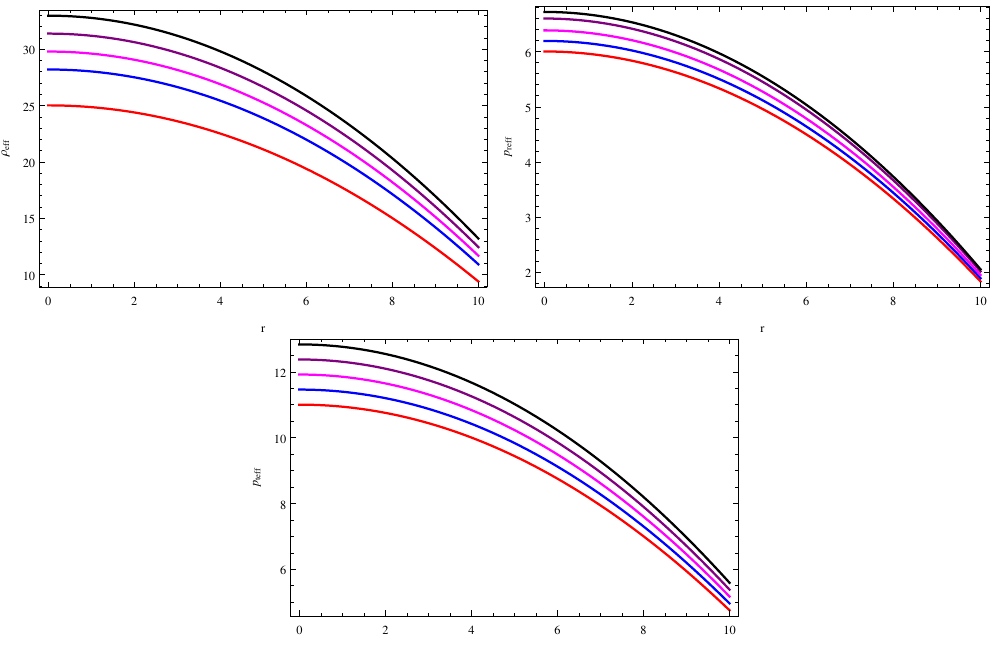
Figure 2. Plot of ρ eff , p eff r and p eff versus r for the strange star candidate LMC X − 4. The red, purple, t magenta, blue and black colors represent, respectively, cases (cid:118) = 0, (cid:118) = 0.5, (cid:118) = 1, (cid:118) = 1.5 and (cid:118) =